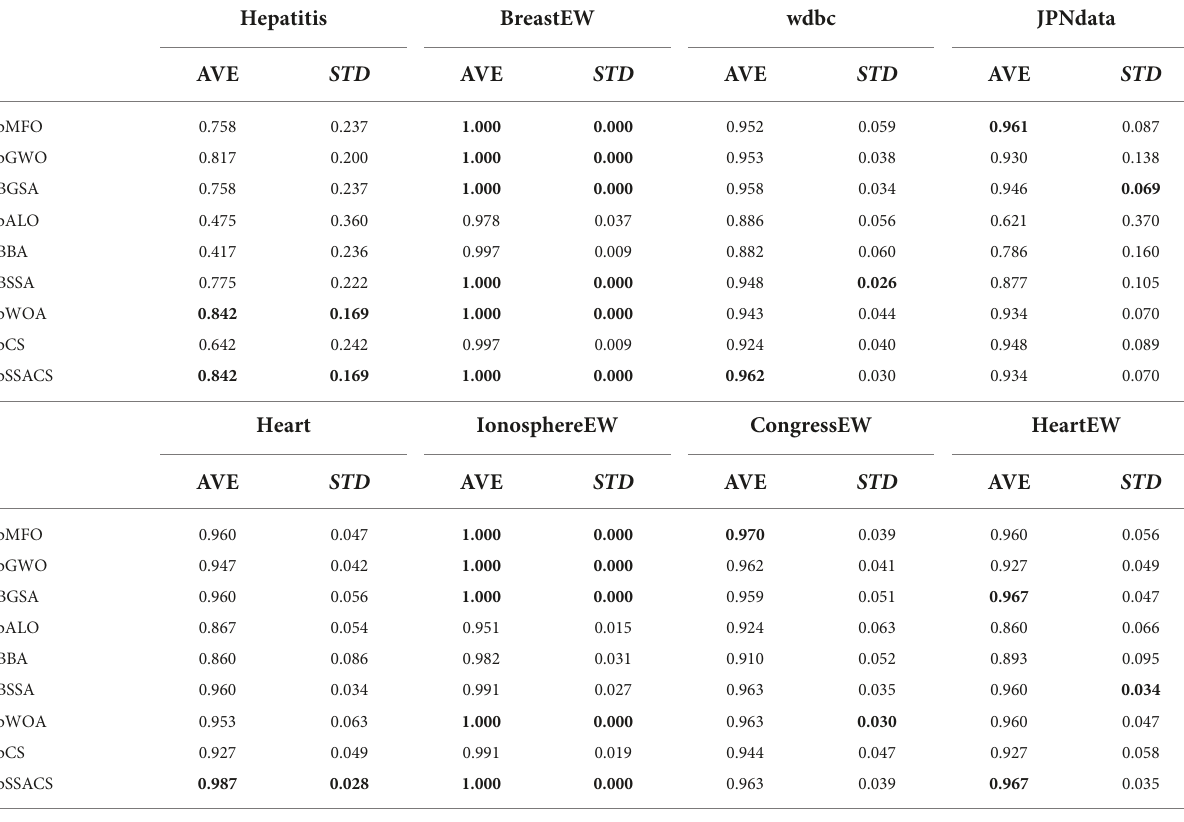
TABLE 11 Sensitivity results of experiments on public datasets.